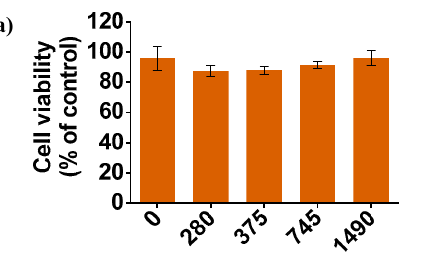
Figure 2. Treatment of mouse macrophage cell line, Raw 264.7, with apple pomace extracts, followed by incubation with lipopolysaccharide (LPS) from Escherichia coli as in vitro model of inflammation. ( a ) Cell viability (% of the control) of Raw 264.7 cells after incubation with polyphenolic-rich hot water extract (pHWE) at 0–1490 μ g/mL in phosphate buffer/ dimethyl sulfoxide (DMSO) (99.9:0.01; v/v). ( b ) Inhibitory effect of pHWE on LPS-induced nitrite production (% of the control) in Raw 264.7 cells. Data represent mean ± standard deviation of 3 independent assays. Different letters indicate statistical significance between pHWE concentrations (a,b,c, and d, p < 0.001) compared to control by one-way ANOVA followed by Tukey’s Multiple comparison test.